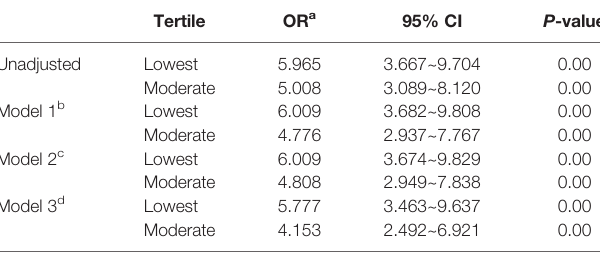
TABLE 4 | Multivariate adjusted odds ratios for the association between SUA levels and PSD at